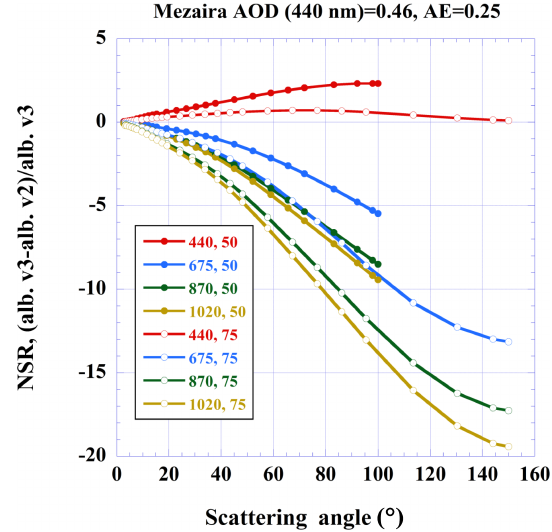
Figure 3. The relative percent difference in normalized sky radi- ances (NSRs) calculated with BRDF parameters from V2 and V3 for the Mezaira